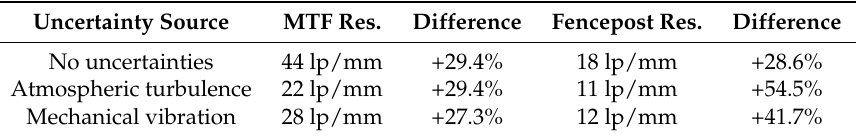
Table 8. Spatial-resolution results for the miniaturised dosimeter under different uncertainty scenarios tabulated against the percentage difference from the original